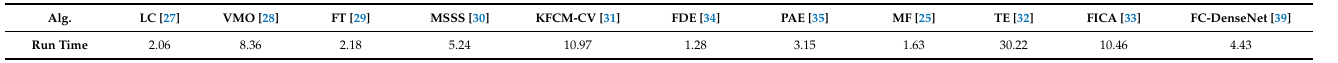
Table 10. Average CPU execution time (s) per frame for each of the eleven algorithms combined with the finally voted Enh3Stage post-processing